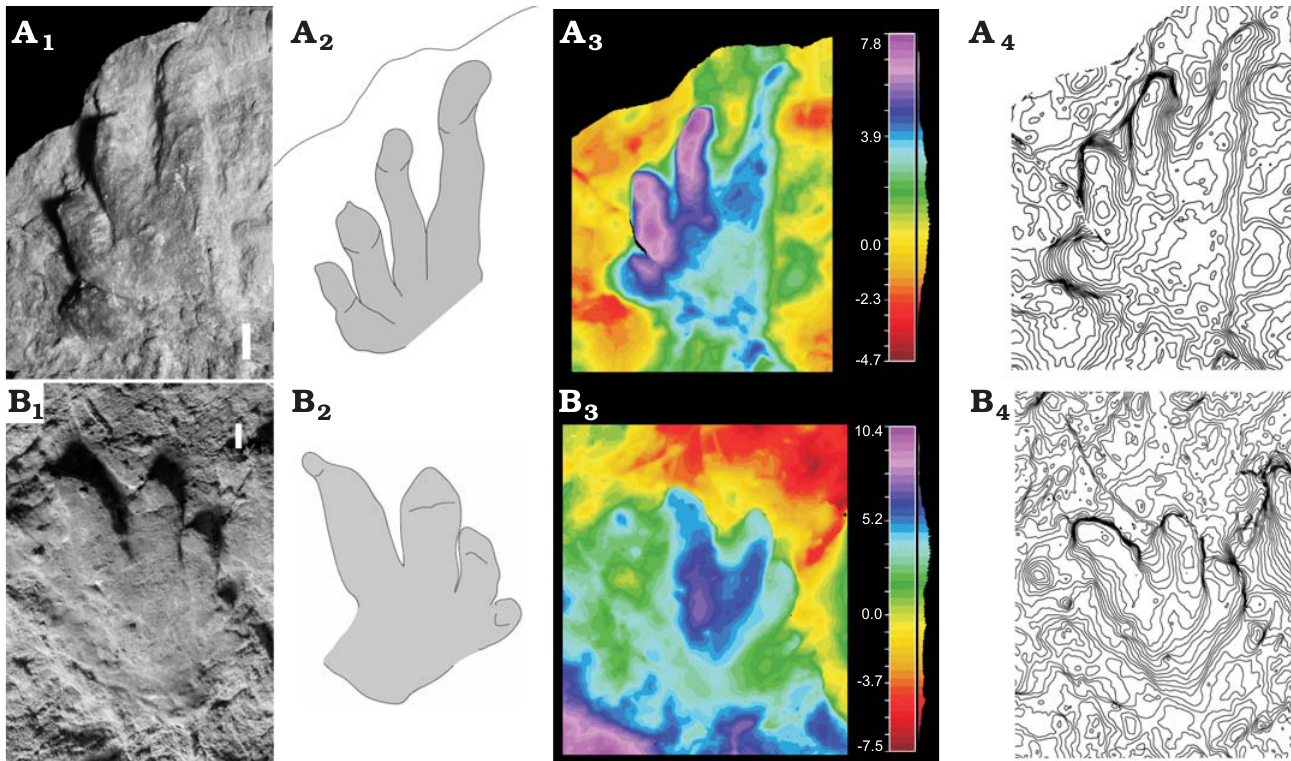
Fig. 3. Putative parareptile trace cf. Capitosauroides isp. from Ulbe (Italy), Lopingian. A . MCV 7, left pes impression showing digits I–IV. B . MCV 11/05, right manual impression showing digits I–IV. Convex hyporelief, spacing 0.5 mm. Photo (A 1 , B 1 ), interpretive drawing (A 2 , B 2 ), false-color depth map (A 3 , B 3 ), contour lines (A 4 , B 4 ). Scale bars 10